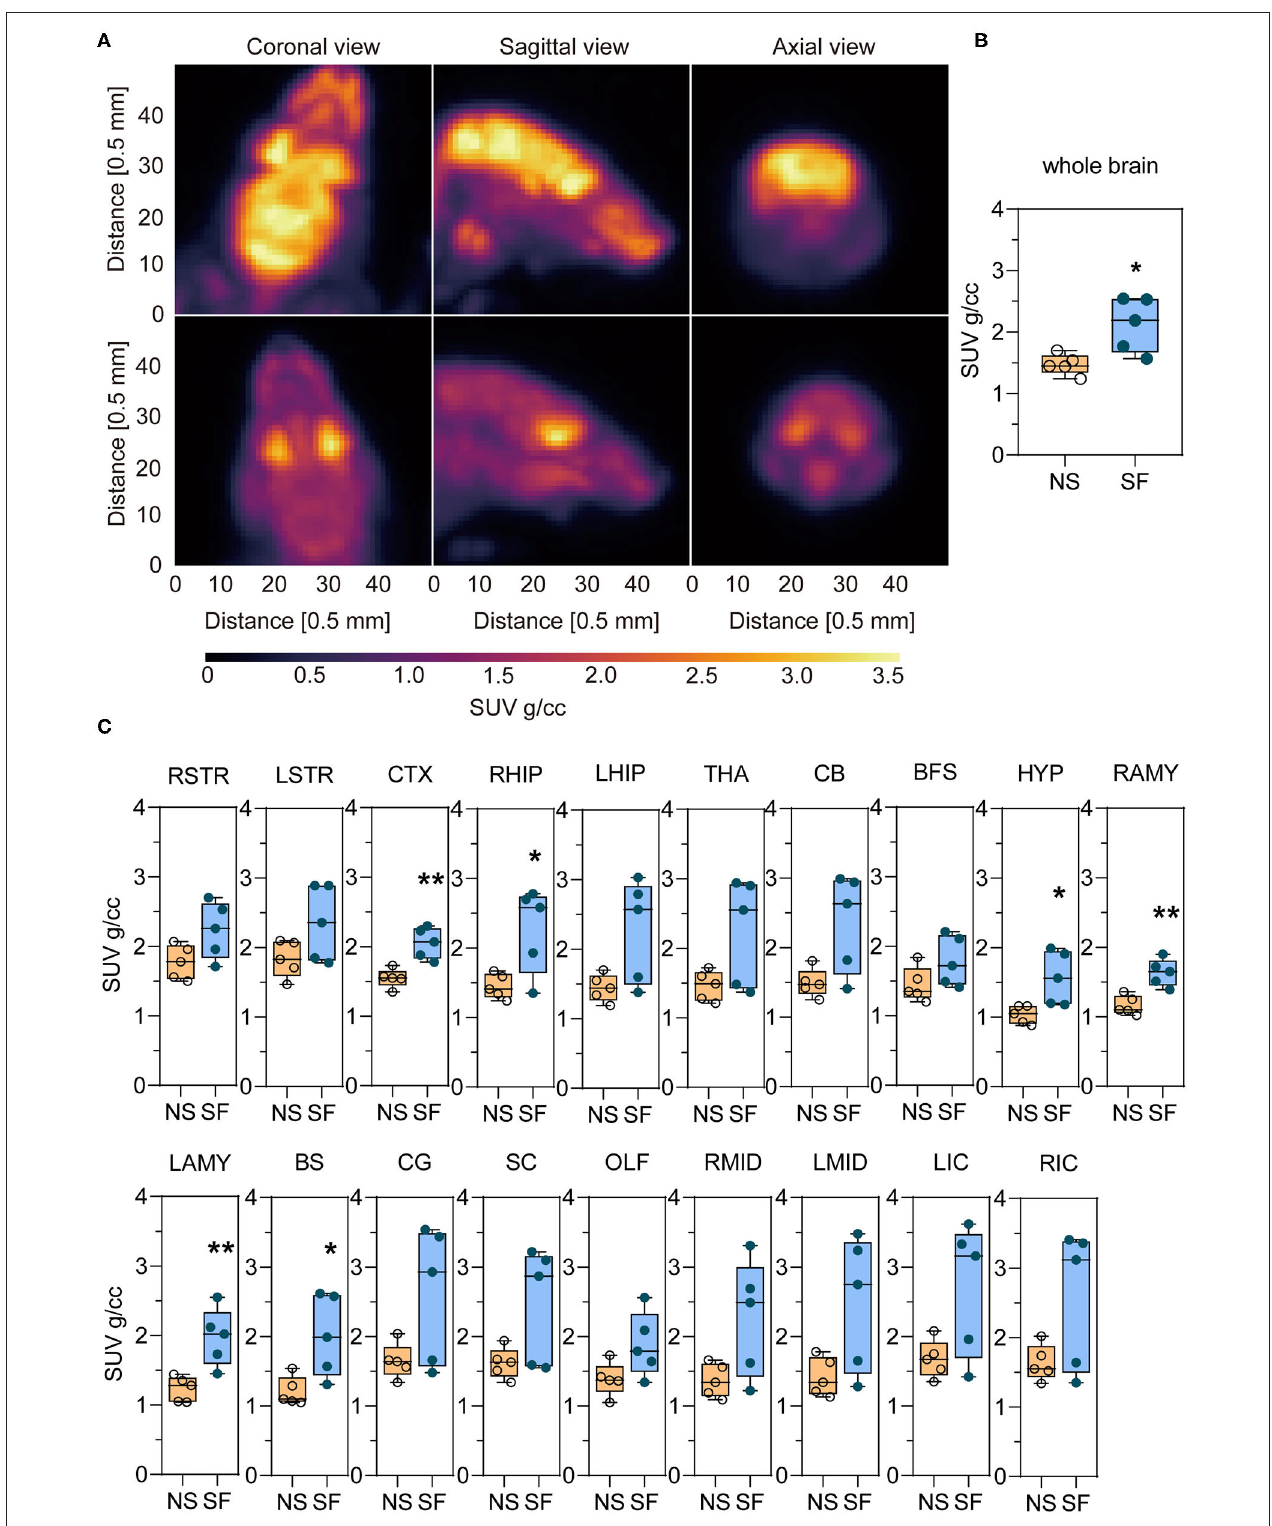
FIGURE 3 | Chronic SF enhances the glucose uptake in the brain monitored by 18 F-FDG-PET/CT. (A) Coronal, sagittal, and axial view of the brain images of an SF (top) and NS (bottom) mouse. (B) Statistical analysis of whole-brain SUV in NS and SF group. n = 5 per group. * P < 0.05. (C) 18 F-FDG uptake in NS and SF mice in different brain regions expressed as SUV. n = 5 per group. * P < 0.05, ** P < 0.01. See Table 1 for the nomenclature of the brain regions.